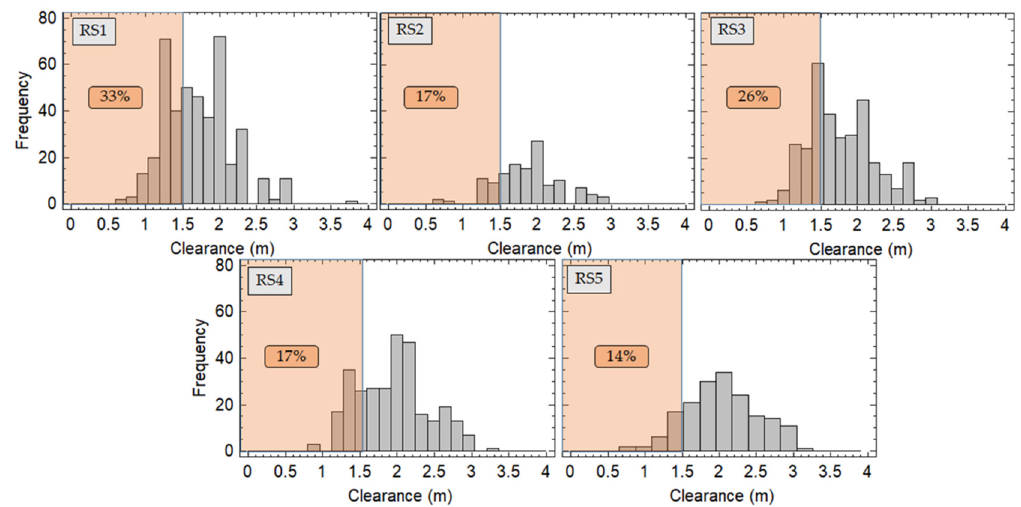
Figure 8. Lateral clearance registered on each road segment and level of non-compliance with Spanish overtaking standards.